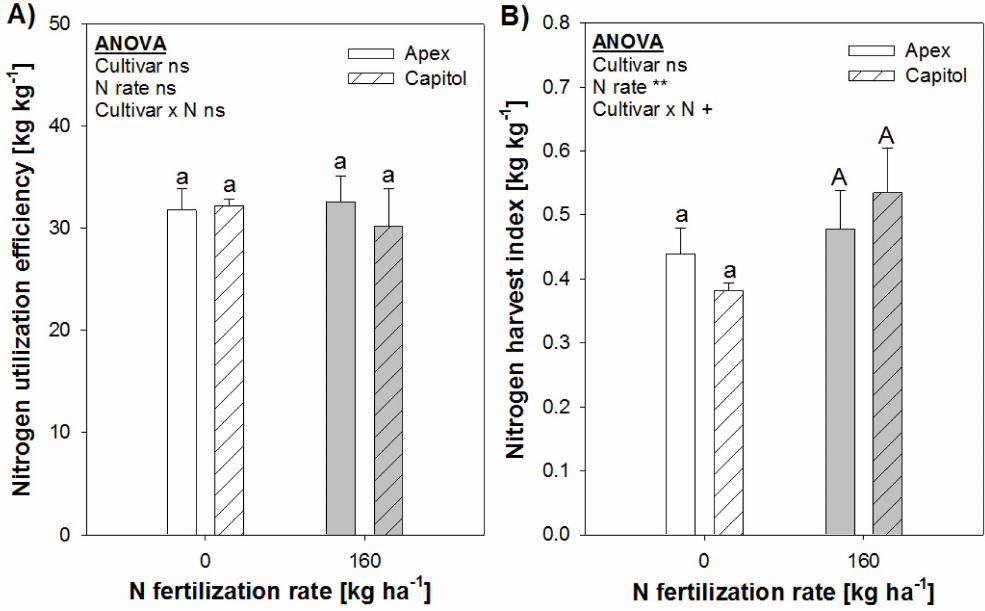
Figure 8. ( A ) Nitrogen utilization efficiency and ( B ) N harvest index at maturity of the winter oilseed-rape line-cultivars Apex and Capitol as affected by the N fertilization rate (N0 and N160). Different lower case and upper case letters on the top of the columns indicate differences between the cultivars within the N fertilizer rates at p < 0.05. ANOVA: + and ** indicate significant differences at p < 0.10 and p < 0.01, respectively. ns = non-significant. The error bars represent the standard deviations of the means ( n =